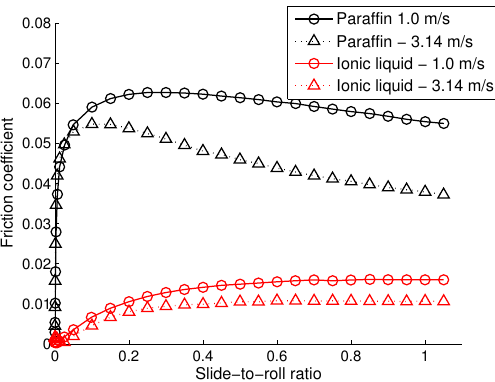
Figure 7. Friction measurements for Paraffin and [Choline] [Proline] at 40 ◦ C and 1.25 GPa. [Choline] [Proline] had a water content of slightly below 15 wt